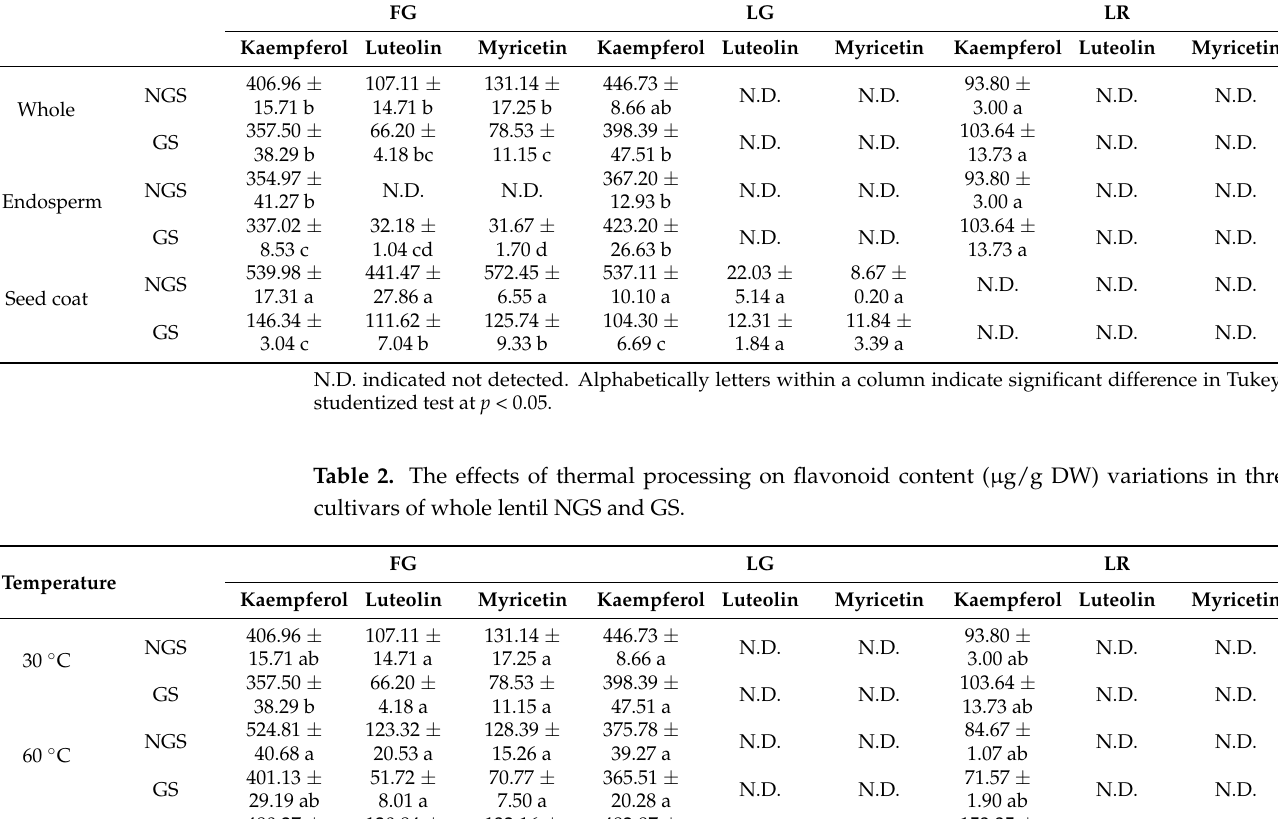
Table 1. The flavonoid content ( µ g/g DW) variations in three cultivars of lentil NGS and GS. FG LG LR